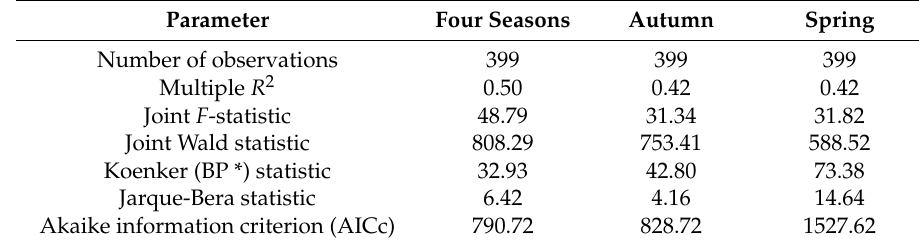
Table 3. Results of OLS (ordinary least regression) regression of pooled four seasons, autumn and spring means infestation with different environmental factors.